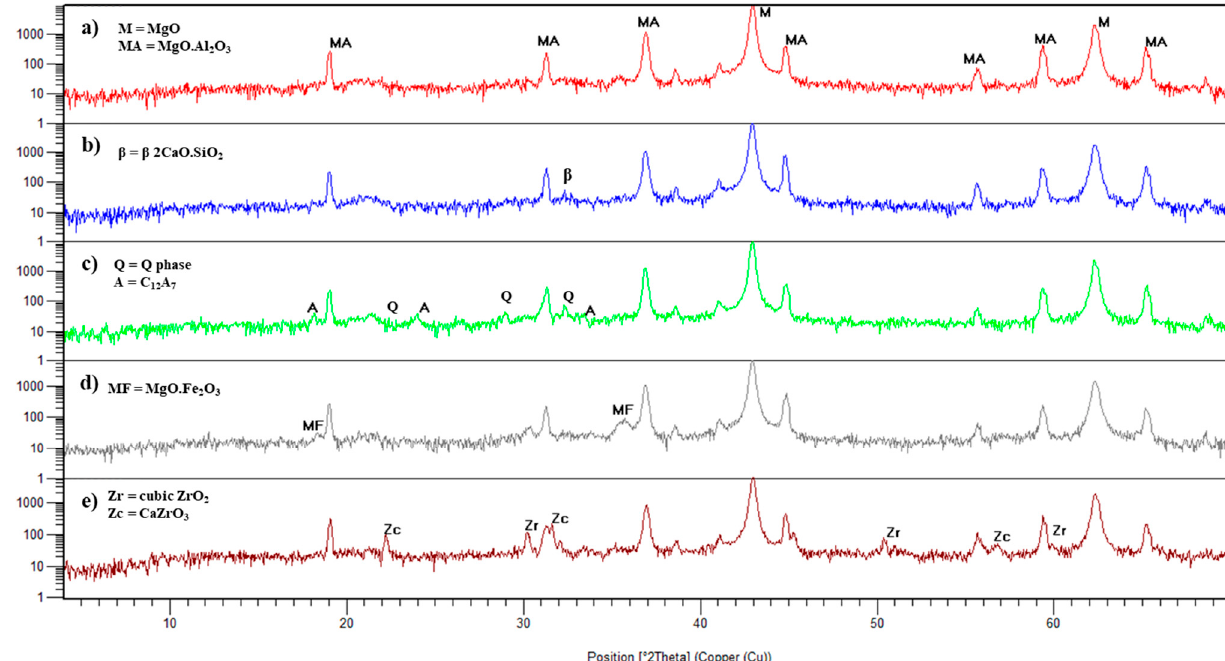
Figure 1. X-ray diffraction patterns of compositions ( a ) A-1, ( b ) A-2, ( c ) A-3, ( d ) A-4 and ( e ) A-5.